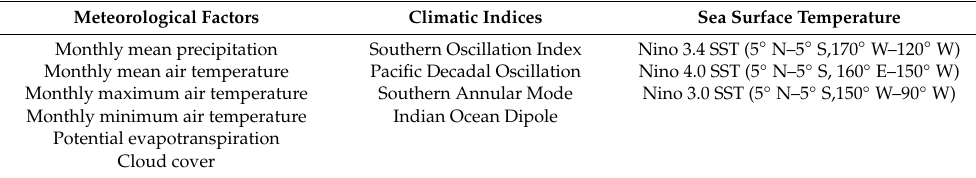
Table 1. Input parameters used for drought forecasting.